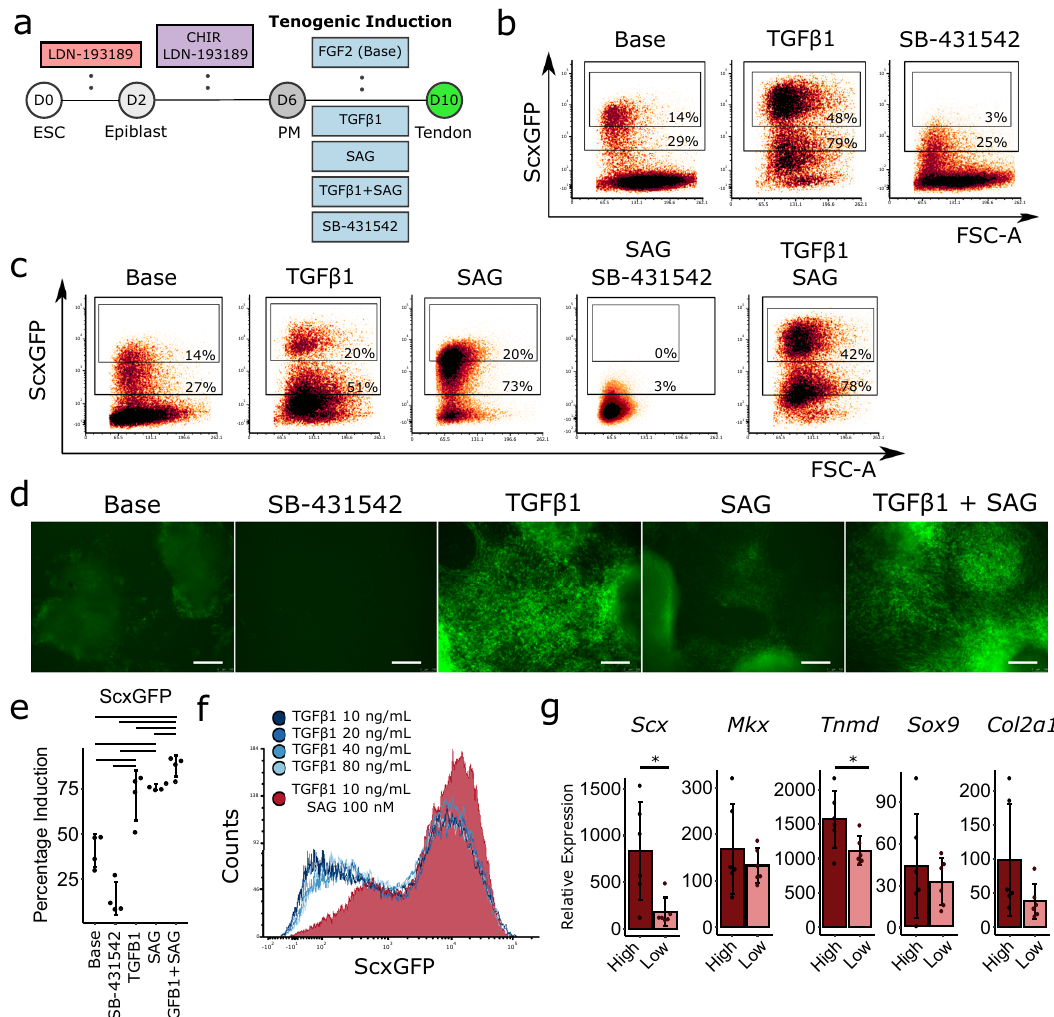
Fig. 1 Hedgehog activation modi fi es mESC responsiveness to TGF β signaling and improves ScxGFP induction. a Schematic of tendon differentiation protocol. Top row indicates common media components. Bottom row indicates media component variables. b , c Flow cytometry plots for ScxGFP induction under tenogenic media conditions. All conditions include FGF2. d Representative images of ScxGFP expression for tenogenic media conditions. All conditions include FGF2. All experiments were repeated a minimum of three times. Scale bar: 100 µ m. e Flow cytometry quanti fi cation of ScxGFP induction for tenogenic media conditions ( n = 4 independent samples, one-way ANOVA with Tukey ’ s post-hoc tests). All experiments were repeated a minimum of three times. Data represented as mean ± SD. f Counts histogram showing ScxGFP induction with increasing concentrations of TGF β 1 compared to TGF β 1 + SAG condition. g Real-time qPCR quanti fi cation of tendon and cartilage genes in sorted ScxGFP hi and ScxGFP lo cells ( n = 6 independent samples, unpaired two-sided Student ’ s t -test). All experiments were repeated a minimum of three times. Data represented as mean ± SD. Bars indicate p < 0.05 between groups. * p < 0.05. Source data are provided as a source data fi